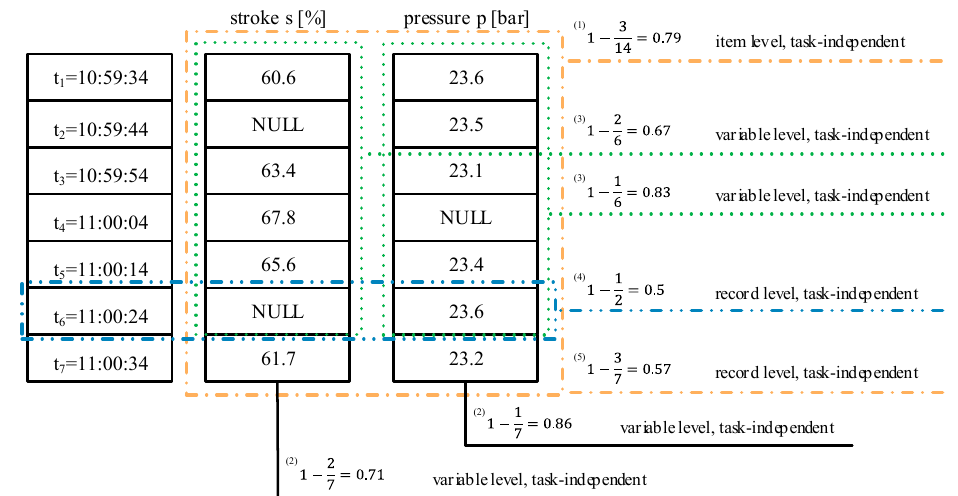
Figure 5. Fictitious data set to illustrate the state-of-the-art metrics for the task-independent attributes on item, variable and record level.